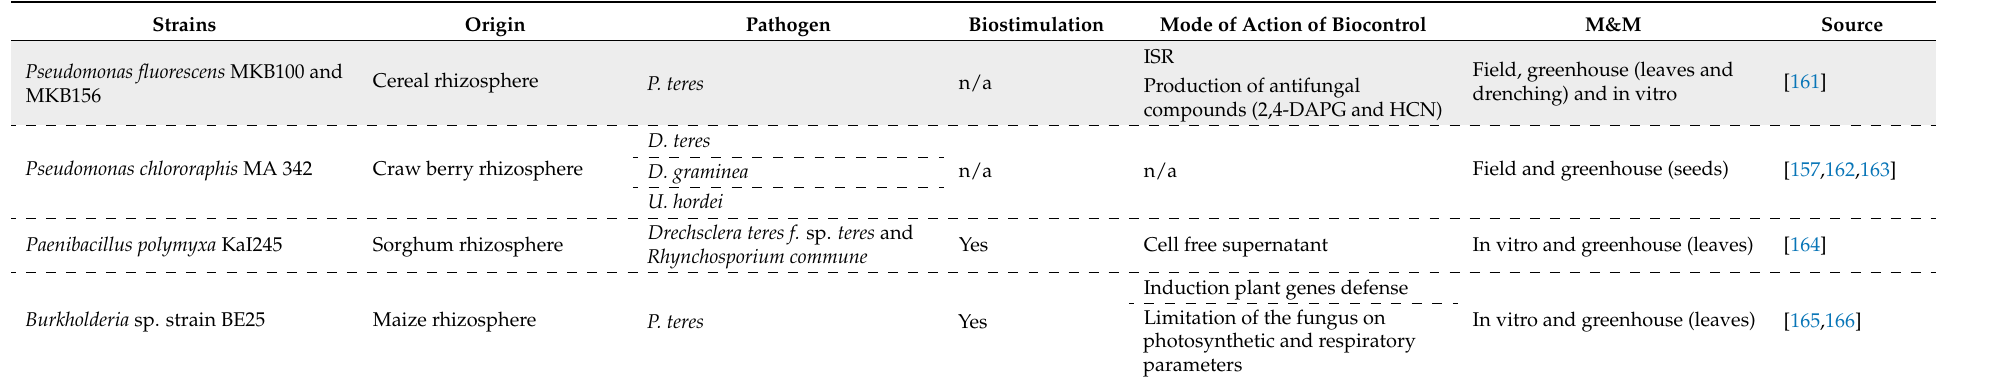
Rows highlighted in grey depict the authors hypothesis for the mode of action of beneficial bacteria based on their preliminary